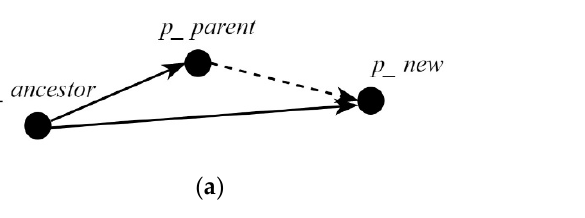
Figure 8. Secondary selection of the parent node: ( a ) reset the parent node and ( b ) abort resetting the parent node.